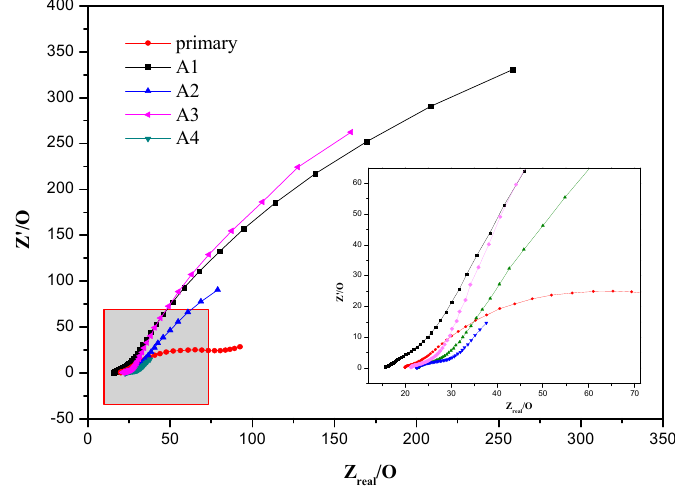
Figure 5. Impedance spectra (Nyquist) of anodic carbon felt of MFCs (A1: 0.1 g zero-valent iron; A2: 0.5 g zero-valent iron; A3: 1 g zero-valent iron; A4: no zero-valent iron). 0.5 g zero-valent iron; A3: 1 g zero-valent iron; A4: no zero-valent